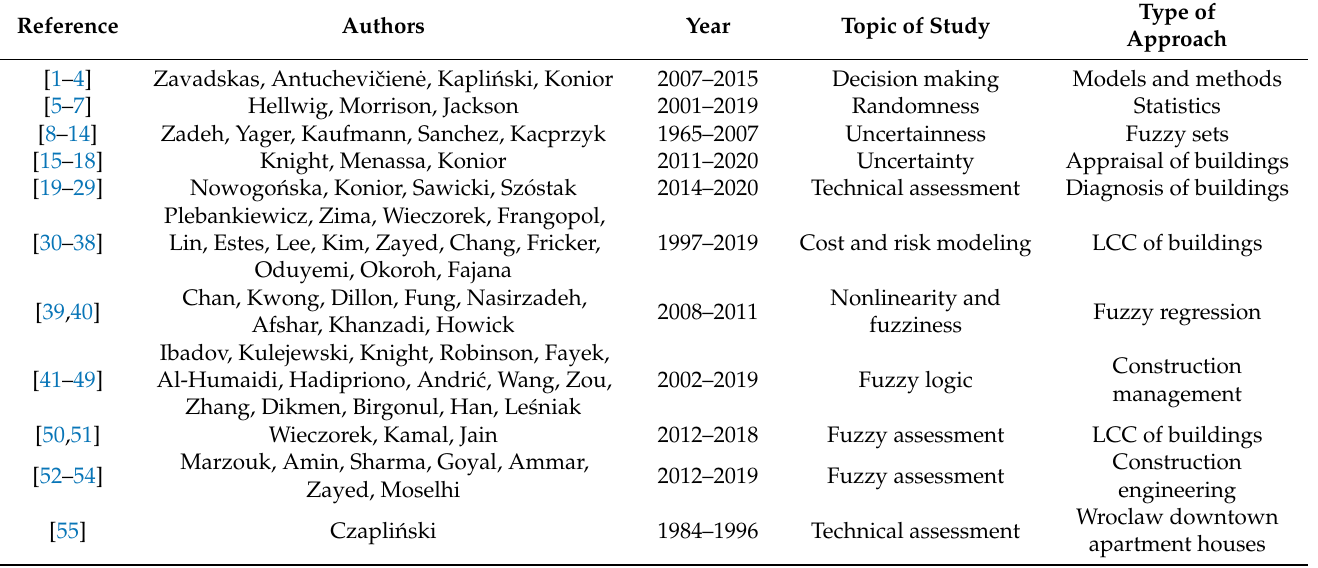
Table 1. Summary of references, authors, year of publication, topics of study, and type of